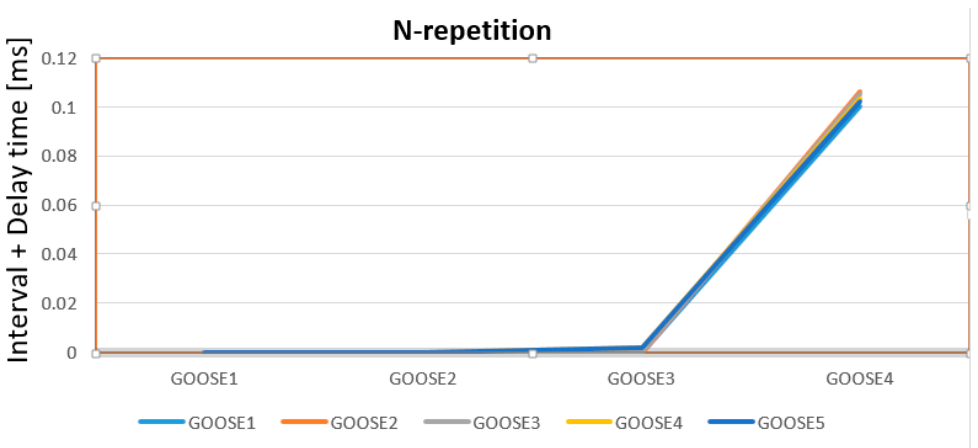
Figure 15. The structure of IED SCL and GOOSE mapping.